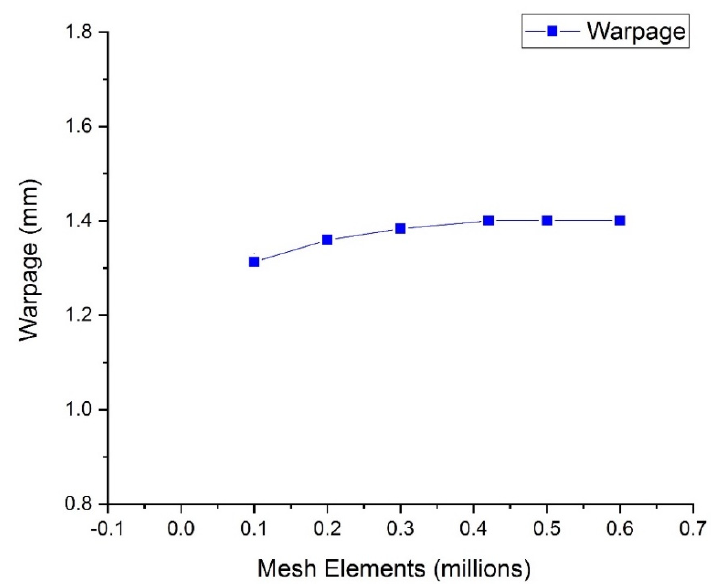
Figure 4. Mesh independence Test.